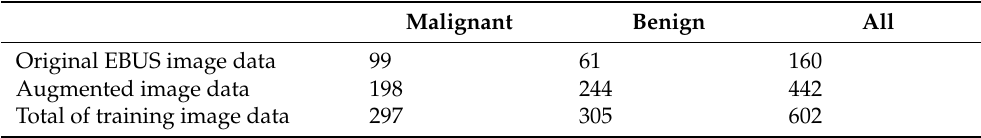
Figure 3. Data augmentation for malignant and benign images. Data augmentation combines both malignant strategy and benign strategy [26] to balance data in both training classes; therefore, the images in malignant class were rotated but were not flipped because there were more malignant images than benign images. From 200 EBUS images, 160 images (80% of the dataset) were used as training data and 40 images (20% of the dataset) were used as test data. After augmentation, the total number of training data for both classes increased from 160 to 602. The number of augmented malignant and benign images is shown in Table 2. Table 2. Distribution of EBUS images after class balancing.